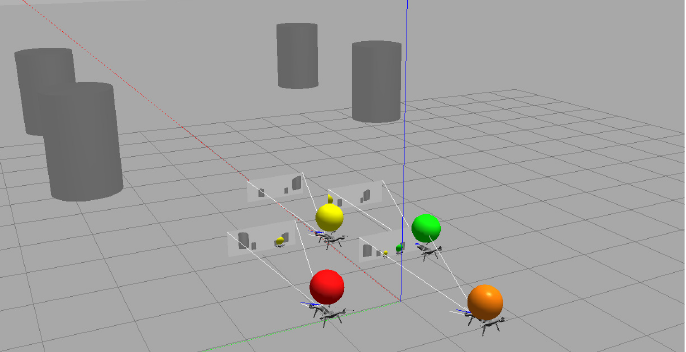
Figure 11. Gazebo simulation environment with four